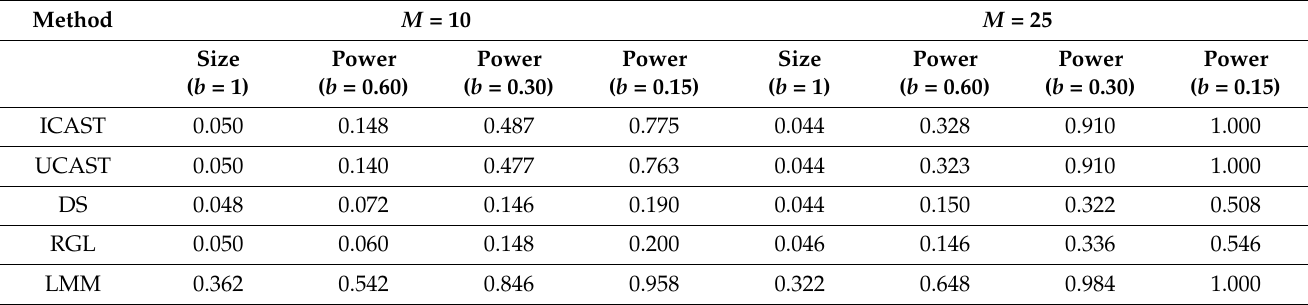
Table 1. Empirical size (type-I error rate) and power performances of different methods for clustered data with uninformative cluster sizes under Simulation Scenario 1. Here M is the number of clusters and b represents the true effect-size where b = 1 denotes H 0 is true and any other value of b denotes H 0 is false. The nominal/target size (type-I error rate) is 0.05 and empirical size of any valid test should not exceed 0.05 irrespective of its